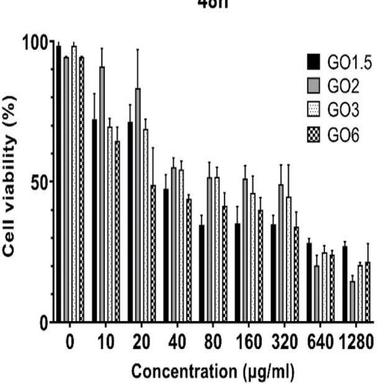
Comparing biocompatibility of different concentrations (GO1.5, GO2, GO3, and GO6) using MTT assay at 48 and 72 h.